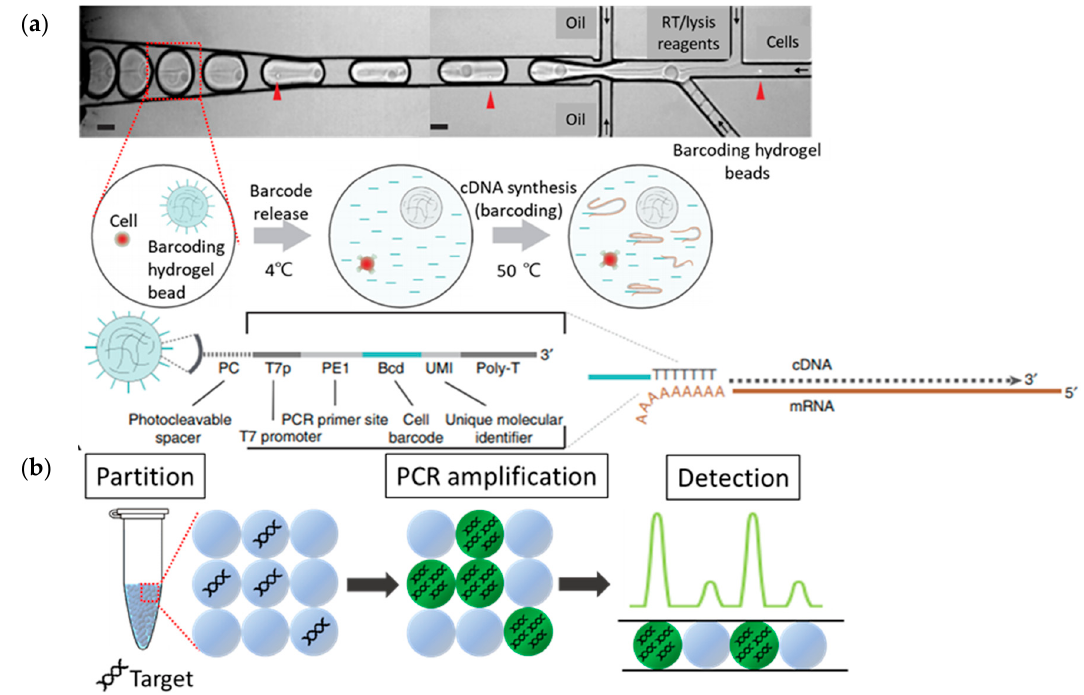
Figure 2. ( a ) DMF-based single cell transcriptome barcoding and genomic sequencing. in drops, reproduced with permission from [18], published by Springer Nature, 2016. ( b ) Digital PCR for the absolute quantification of target DNA. Target sequences are encapsulated and amplified in pico to nanoliter droplets. Then, a number of target molecules can be quantified by counting fluorescent droplets.